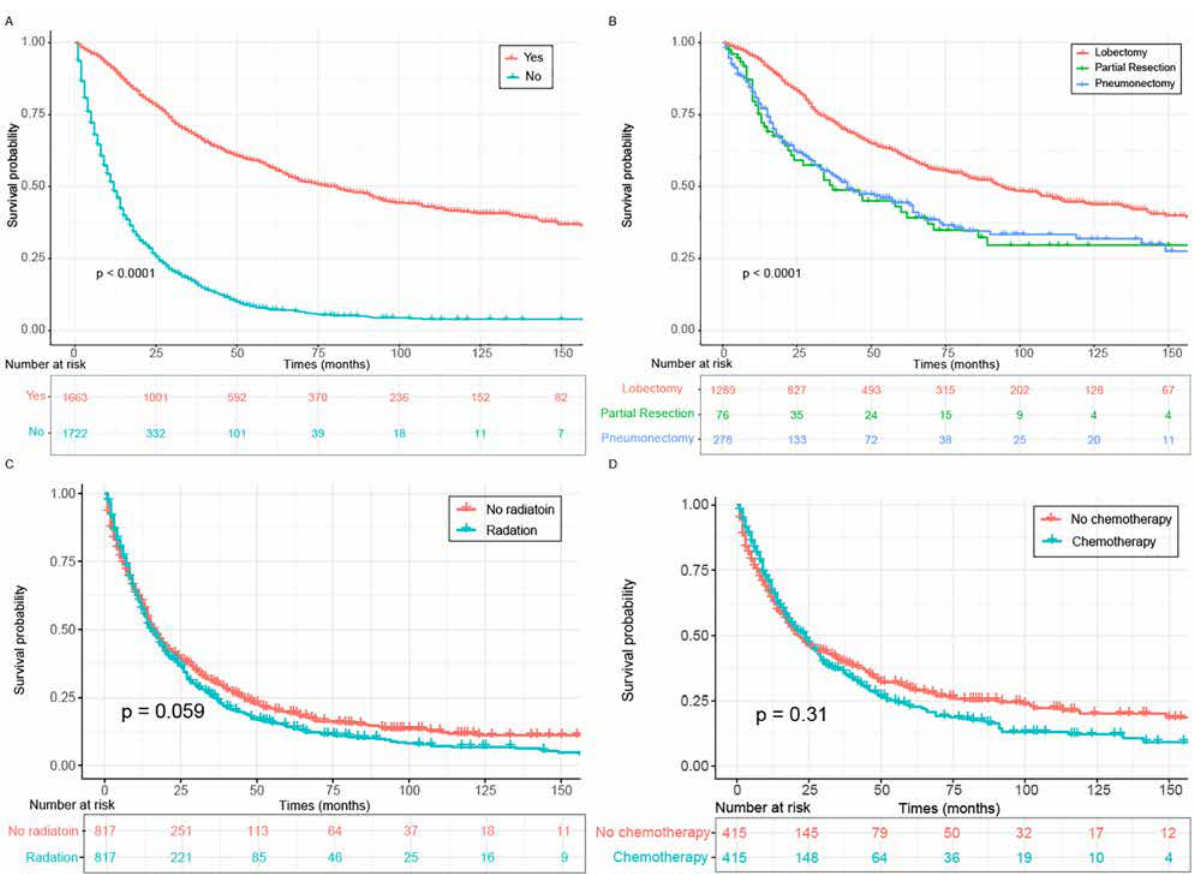
Figure 3: OS for primary pulmonary PA patients classified by (A) surgery. (B) different surgery type. (C) radiation after PSM analysis. (D) chemotherapy after PSM